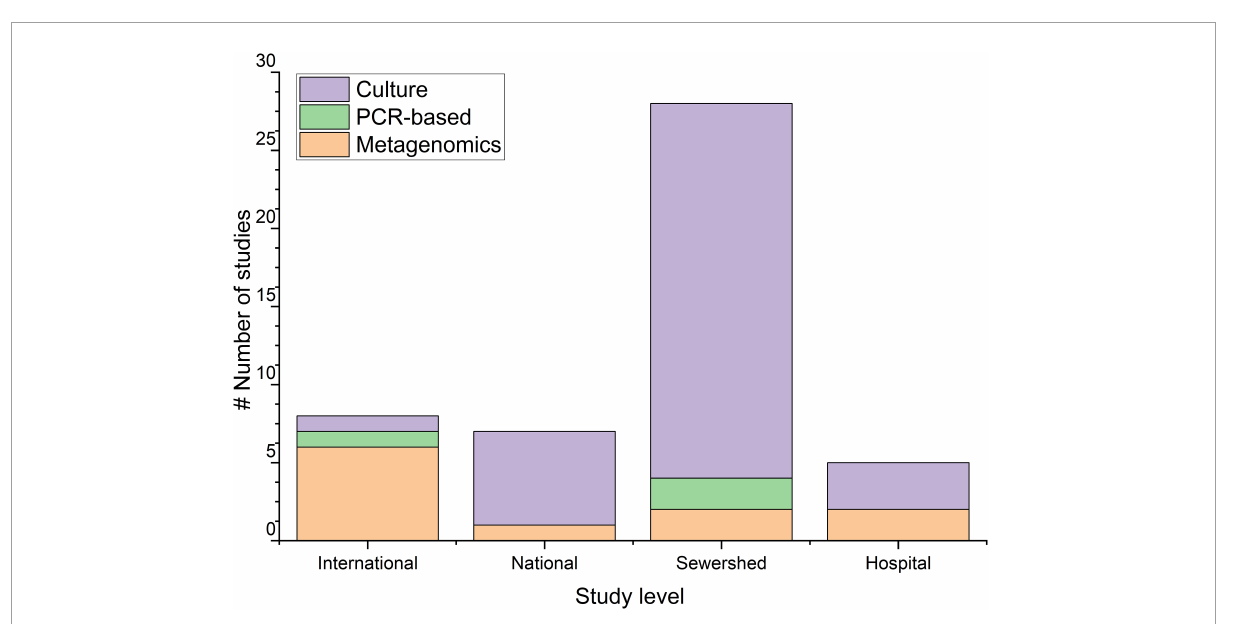
FIGURE2 The number of studies conducted at different study levels. International, studies conducted in more than two countries, National/Regional, studies conducted in more than one wastewater treatment plant inside a country, Sewershed, studies conducted within a sewershed, Hospital, studies conducted in a